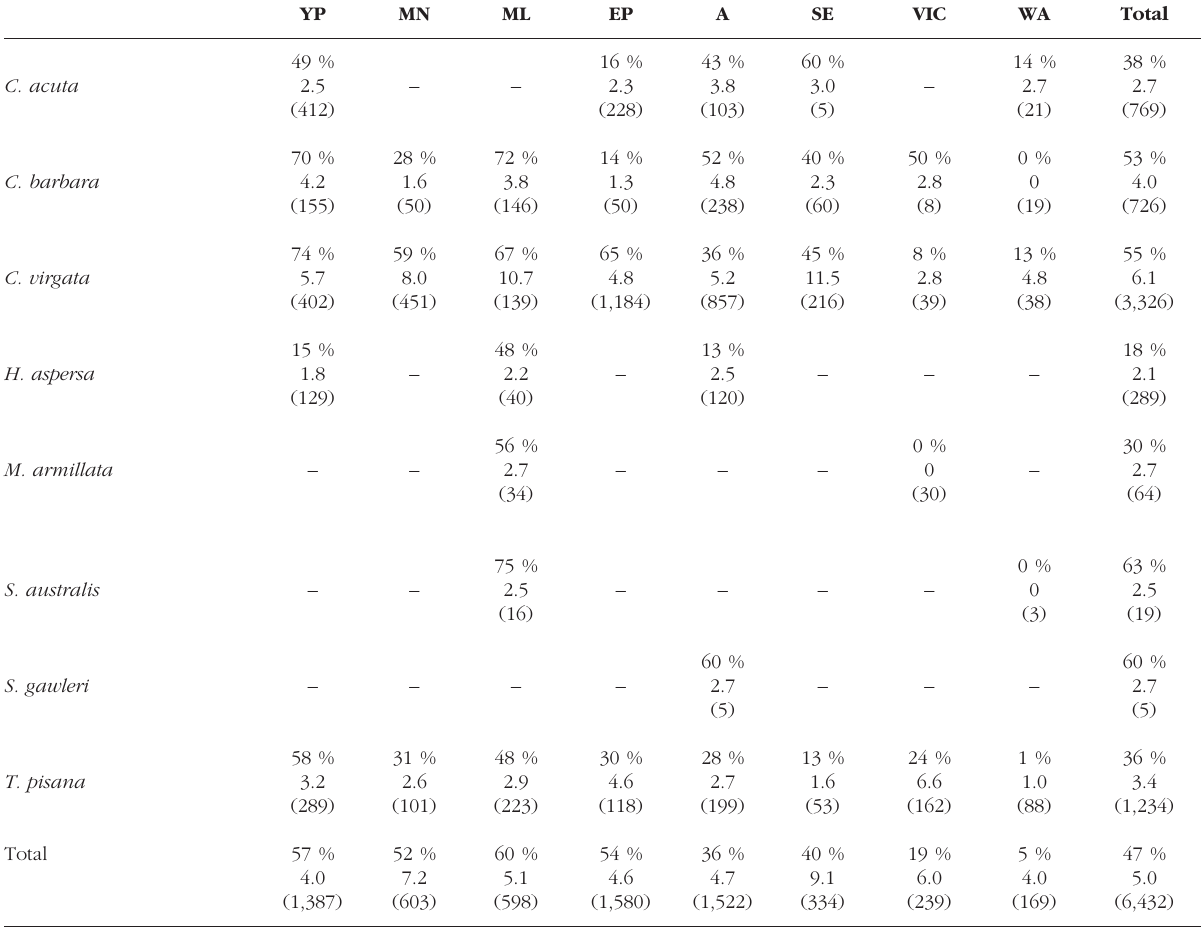
Table I. – Percentages of snails infected and mean numbers per infected snail of B. cribbi metacercariae in land snails across eight geo- graphical districts of southern Australia. Collection sites were grouped into six districts in South Australia: Yorke Peninsula (YP), Mid-North (MN), Murray Lands (ML), Eyre Peninsula (EP), Adelaide/Adelaide Hills/Barossa Valley/Fleurieu Peninsular (A) and the South East (SE). Other collection sites were in the states of Western Australia (WA) and Victoria (VIC). ( ) = number of snails examined.